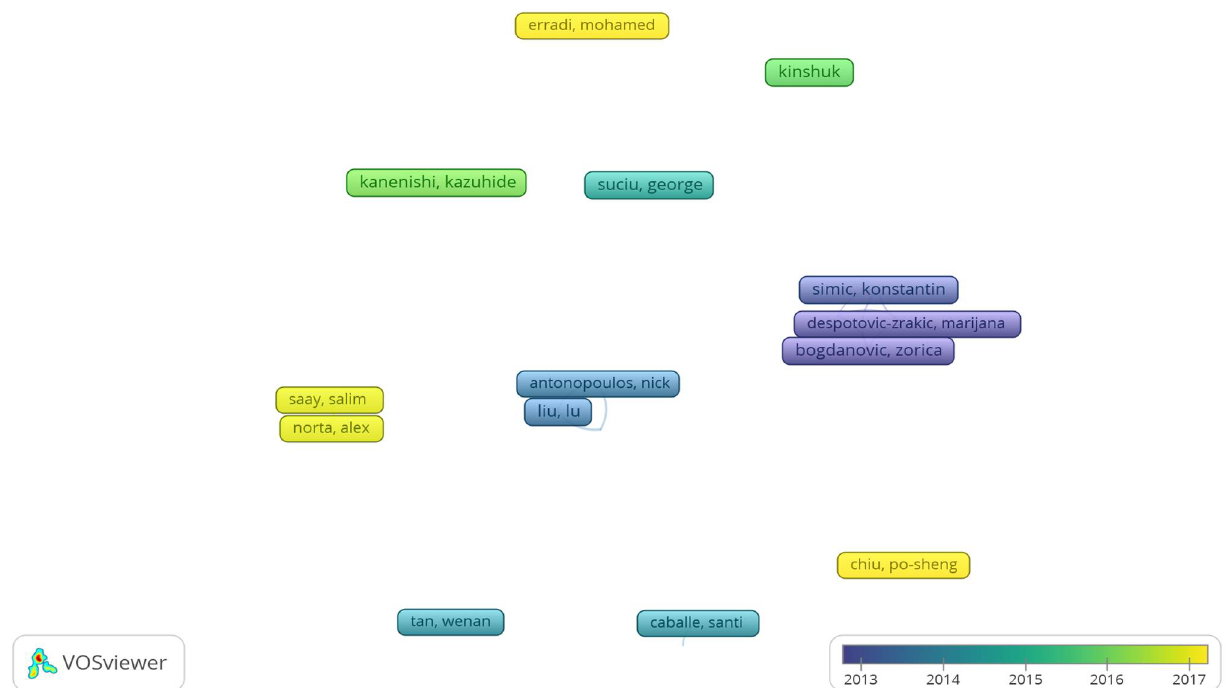
Figure 13. Network visualization map based on text data—Co-authorship.